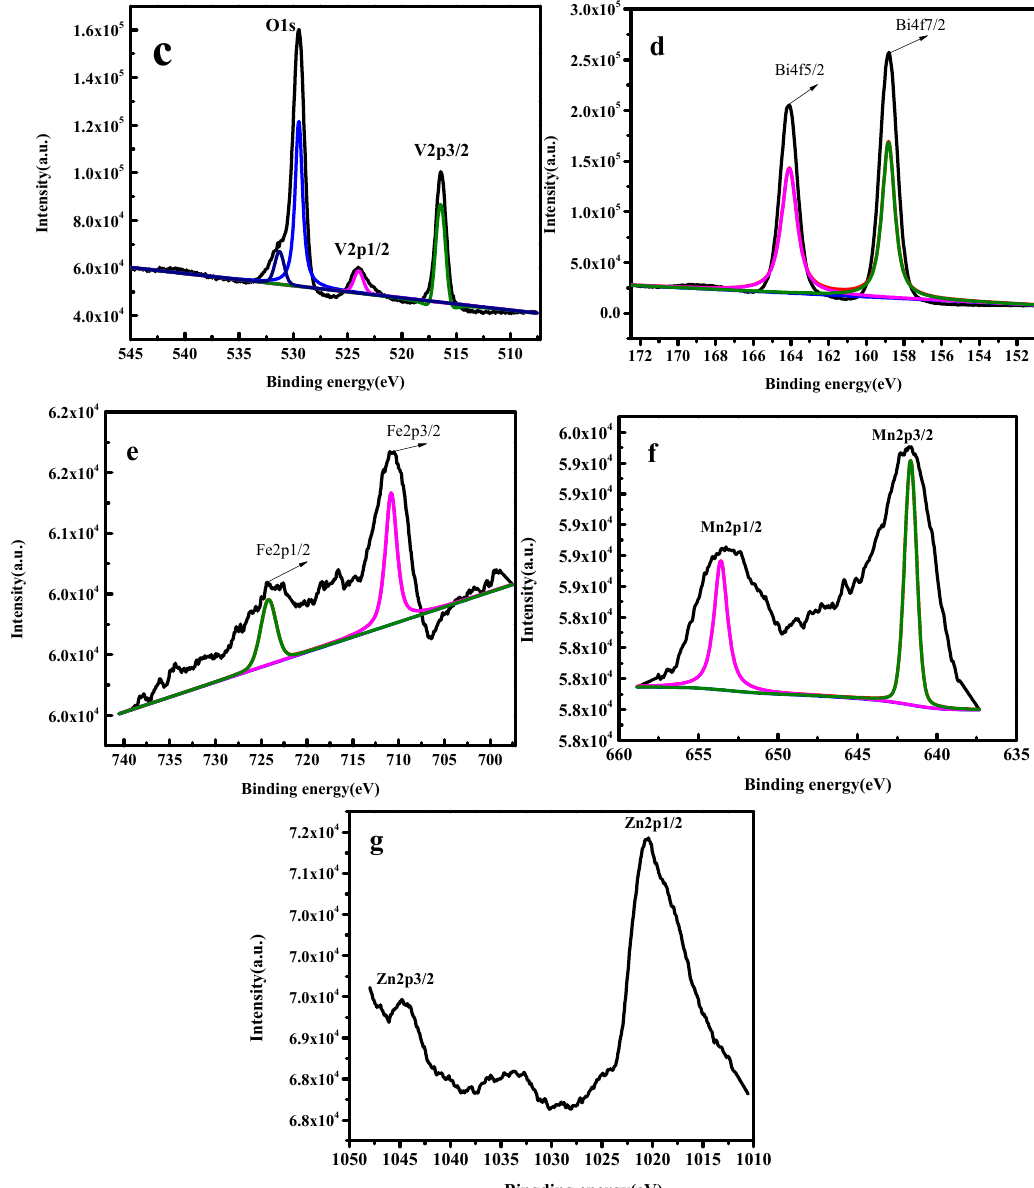
Figure 3. XPS spectra of the magnetic composite ( a ) fully scanned spectra of BiVO 4 /Mn 1 − x Zn x Fe 2 O 4 and Ag/BiVO 4 /Mn 1 − x Zn x Fe 2 O 4 ; ( b – g ) narrow scan spectrum of Ag3d, O1s and V2p, Bi4f, Fe2p, Mn2p, and Zn2p of Ag/BiVO 4 /Mn 1 − x Zn x Fe 2 O 4.